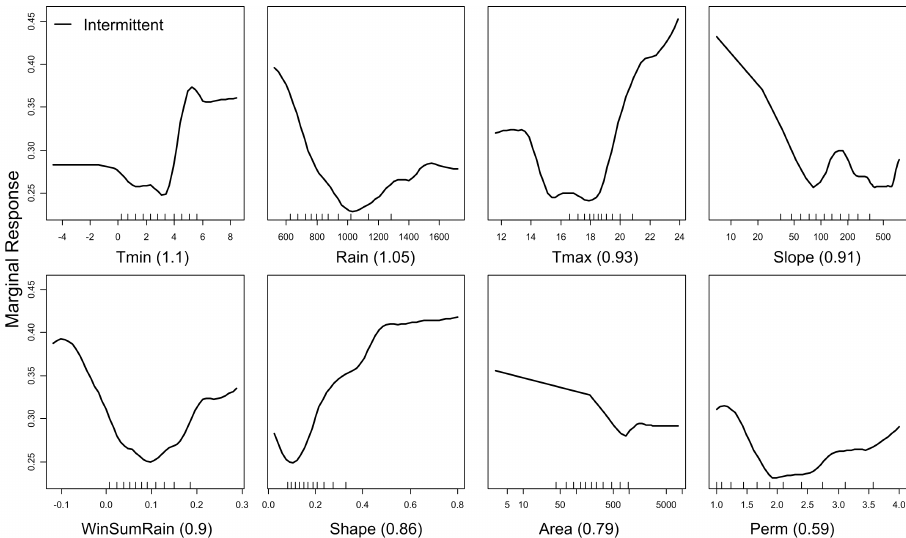
Fig. 8. Partial dependence of the probability of intermittence for each of significant environmental variables retained in the reduced model. The variables are shown in order of importance from the top-right to the bottom left. The plots show the marginal contribution to probability of flow intermittence (y-axis) as a function of the variables (i.e., the other contributing variables were held at their mean). The rug plots on the horizontal axes show deciles of the predictors. The value in brackets on the horizontal axis is the importance measure.